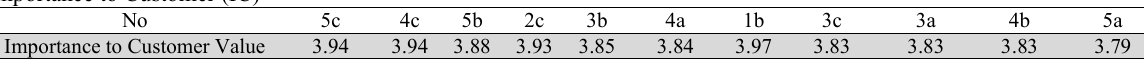
Importance to Customer (IC) Importance to Customer Value